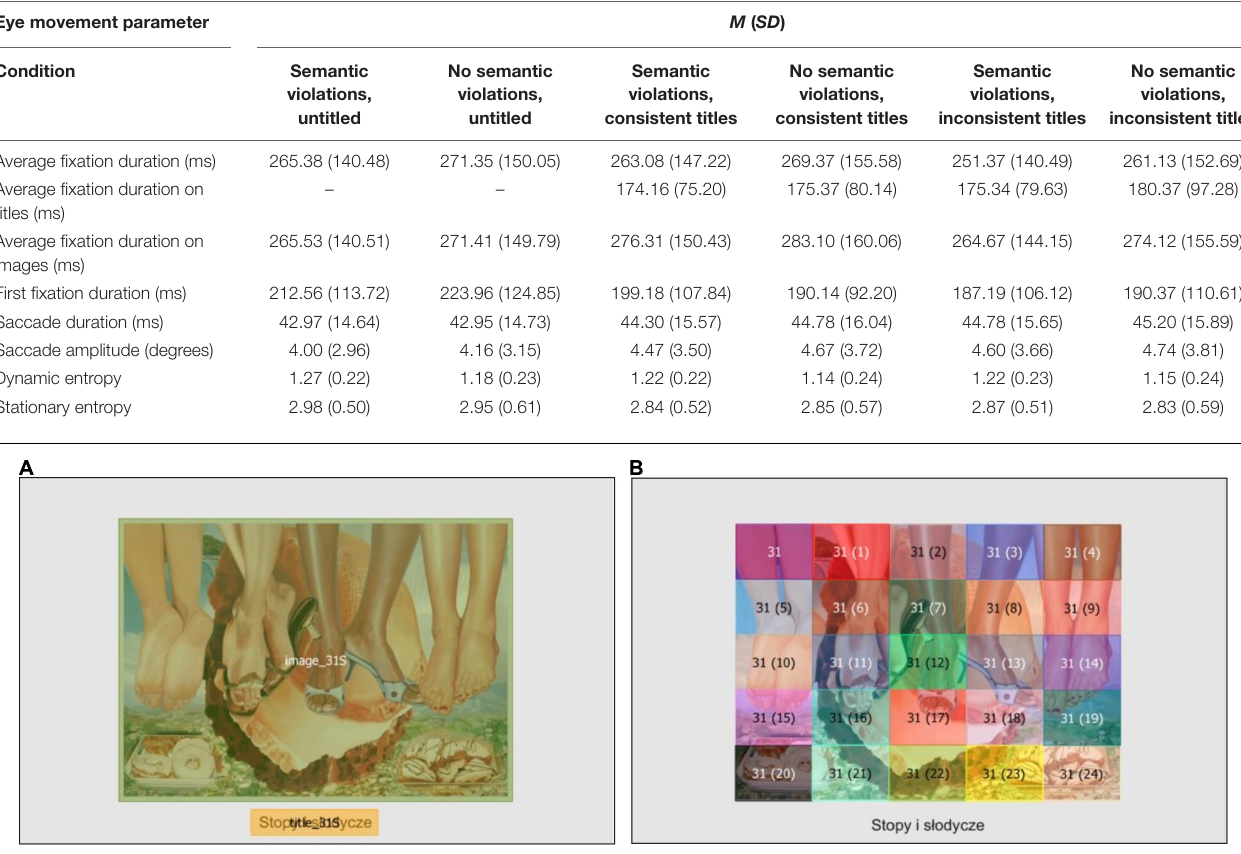
FIGURE 3 | Examples of Areas of Interest (AOIs) used for the analyses of overall eye movement parameters, temporal dynamics of fixation, and the entropy measures; separate AOIs for image and title (A) , 5 × 5 gridded AOIs used for entropy measures (B) .